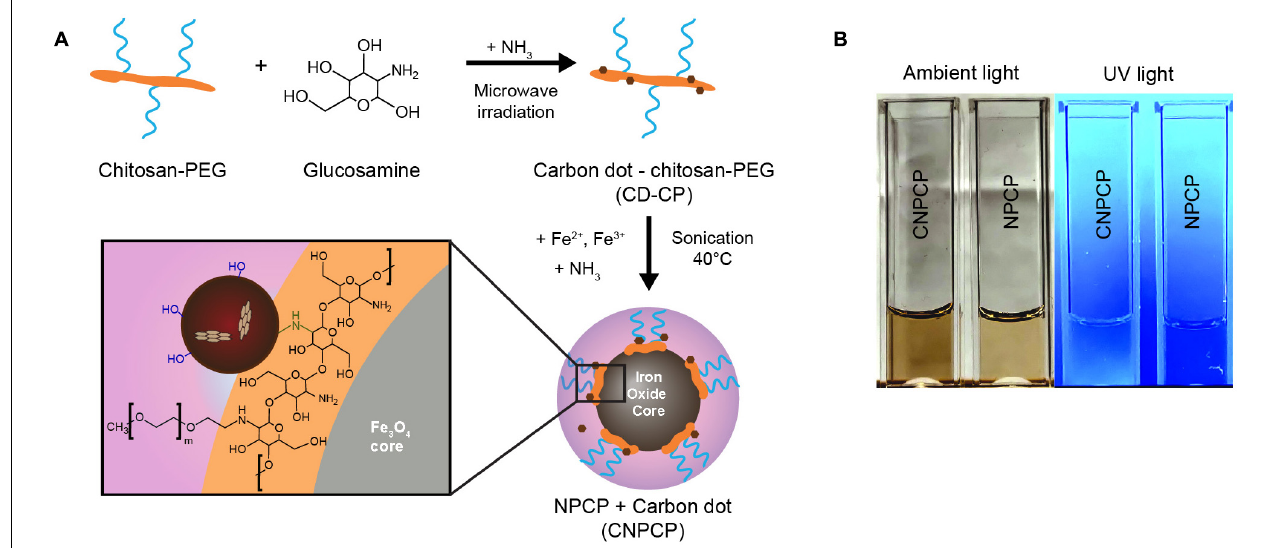
FIGURE 1 | Overview of synthesis of CNPCP. (A) Schematic representation of synthesis of carbon dot-chitosan-PEG (CD-CP) and fluorescent iron oxide nanoparticle (CNPCP). (B) Images of aqueous solutions of CNPCP and NPCP.